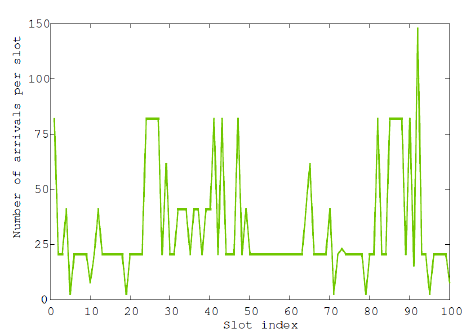
Figure 5. Normalized traffic of